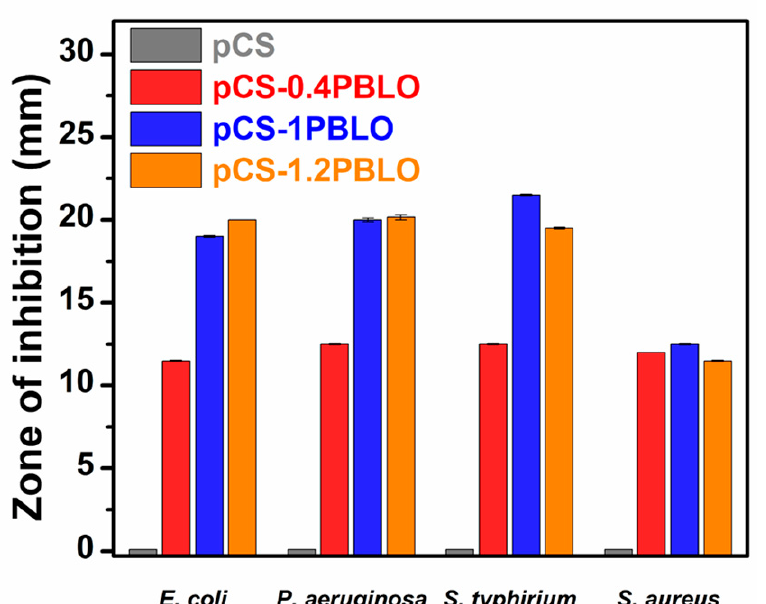
Figure 6. The antibacterial activity of pCS, pCS-0.4PBLO, pCS-1PBLO, and pCS-1.2PBLO against S. auereus , E. coli , P. aeruginosa , and S. typhimurium . Liquid inoculation tests showed that inhibition activities of the pCS-PBLO to E. coli strain was observed at all tested-PBLO concentrations of 0.4%, 1%, and 1.2% (Table 3, Figure S2). However, at low PBLO concentration of 0.4%, the number of bacteria increased after 8 h of co-inoculation. Interestingly, at PBLO concentration of 1.2%, bacteria were killed after 24 h of co-inoculation. It found that the antibacterial activity of CS-PBLO film was lower than film containing Piper betle Linn extract [23], which was due to the composition of volatile phenolic compound during oil preparation process. In general, the addition of PBLO significantly improved the antibacterial activity of control chitosan film. These results indicated that the PBLO can be used as an antibacterial agent in producing the effective food packaging film products. Table 3. Results of time-dependent assays for E. coli. Sample